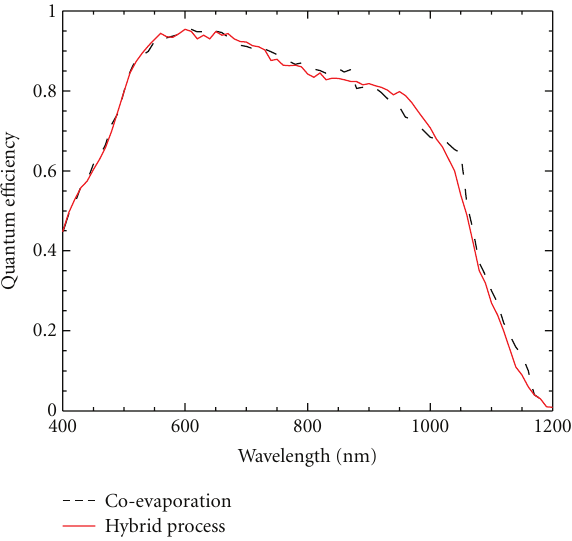
Figure 6: Normalized quantum e ffi ciency ( QE ) characteristics for Cu(In,Ga)Se 2 solar cells deposited by hybrid and coevaporation